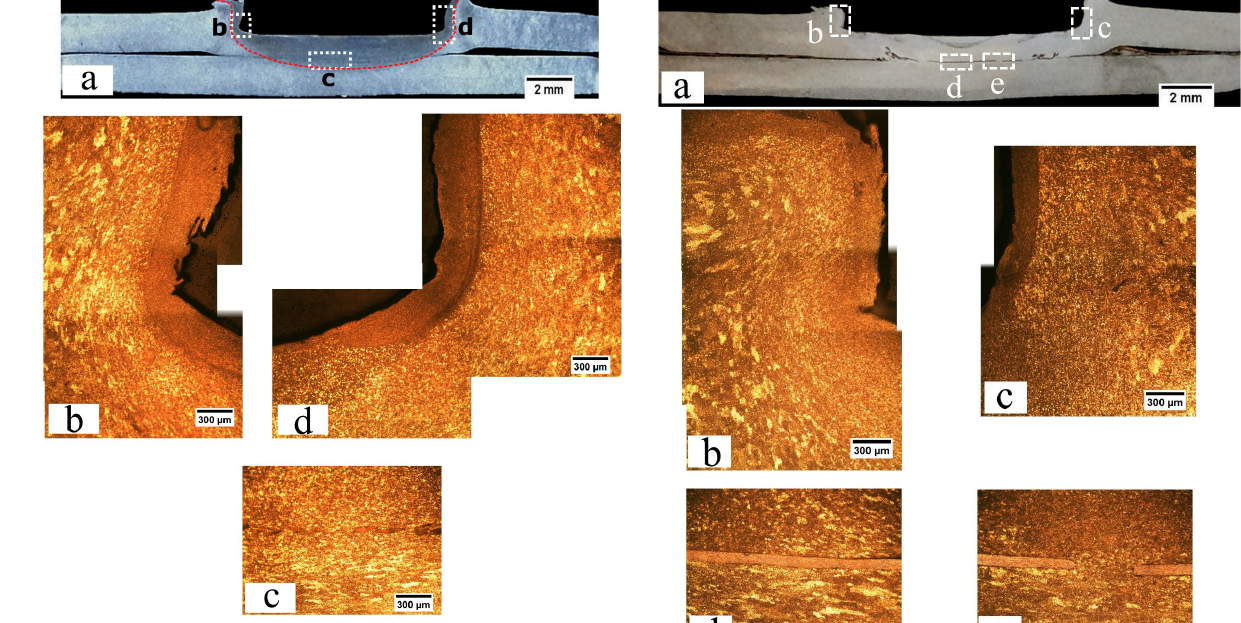
Figure 4: Metallurgical characterisation of weld cross-section with- out Cu interlayer (W7 P-FSSW joint): (a) macrostructure of joints, (b) transition zone in the AS, (c) interface in the centre of joint and (d) transition zone in the RS